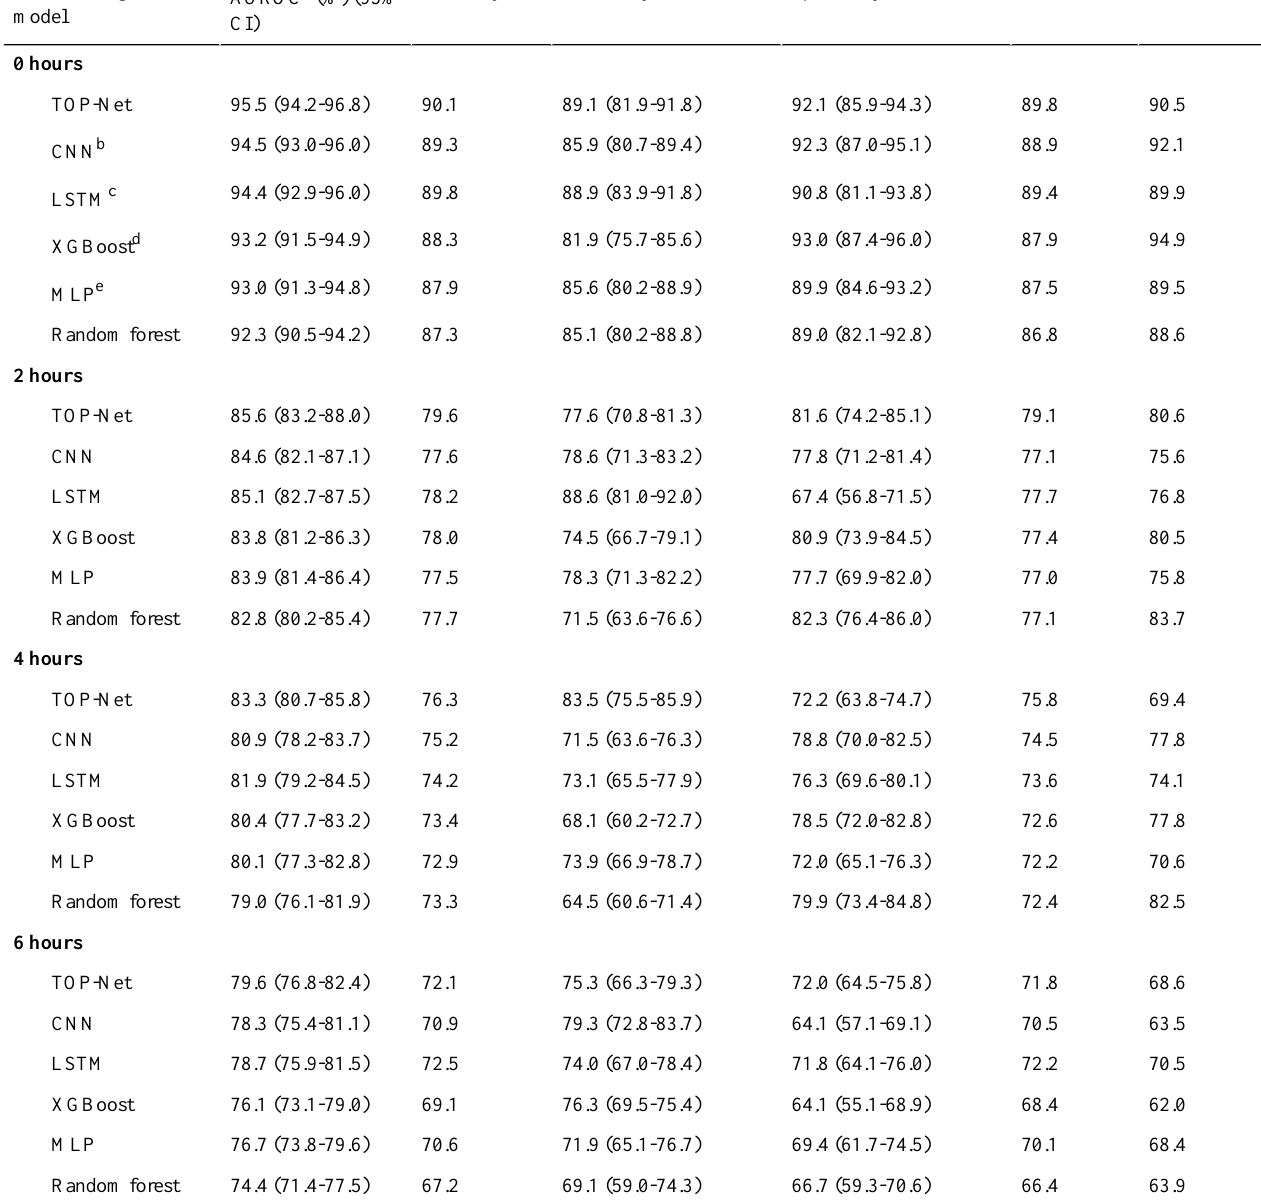
Table 3. The detailed information of performance comparison (TOP-Net vs other